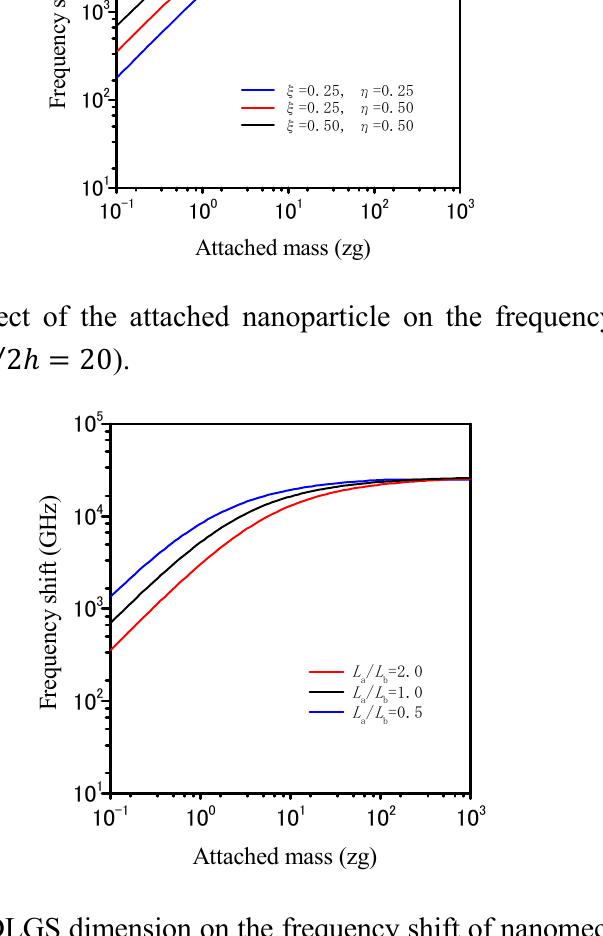
Figure 7. Influence of DLGS dimension on the frequency shift of nanomechanical resonator ( (cid:1838) 2ℎ = 20,⁄ (cid:2022) = (cid:2015) = 0.5 (cid:3029)